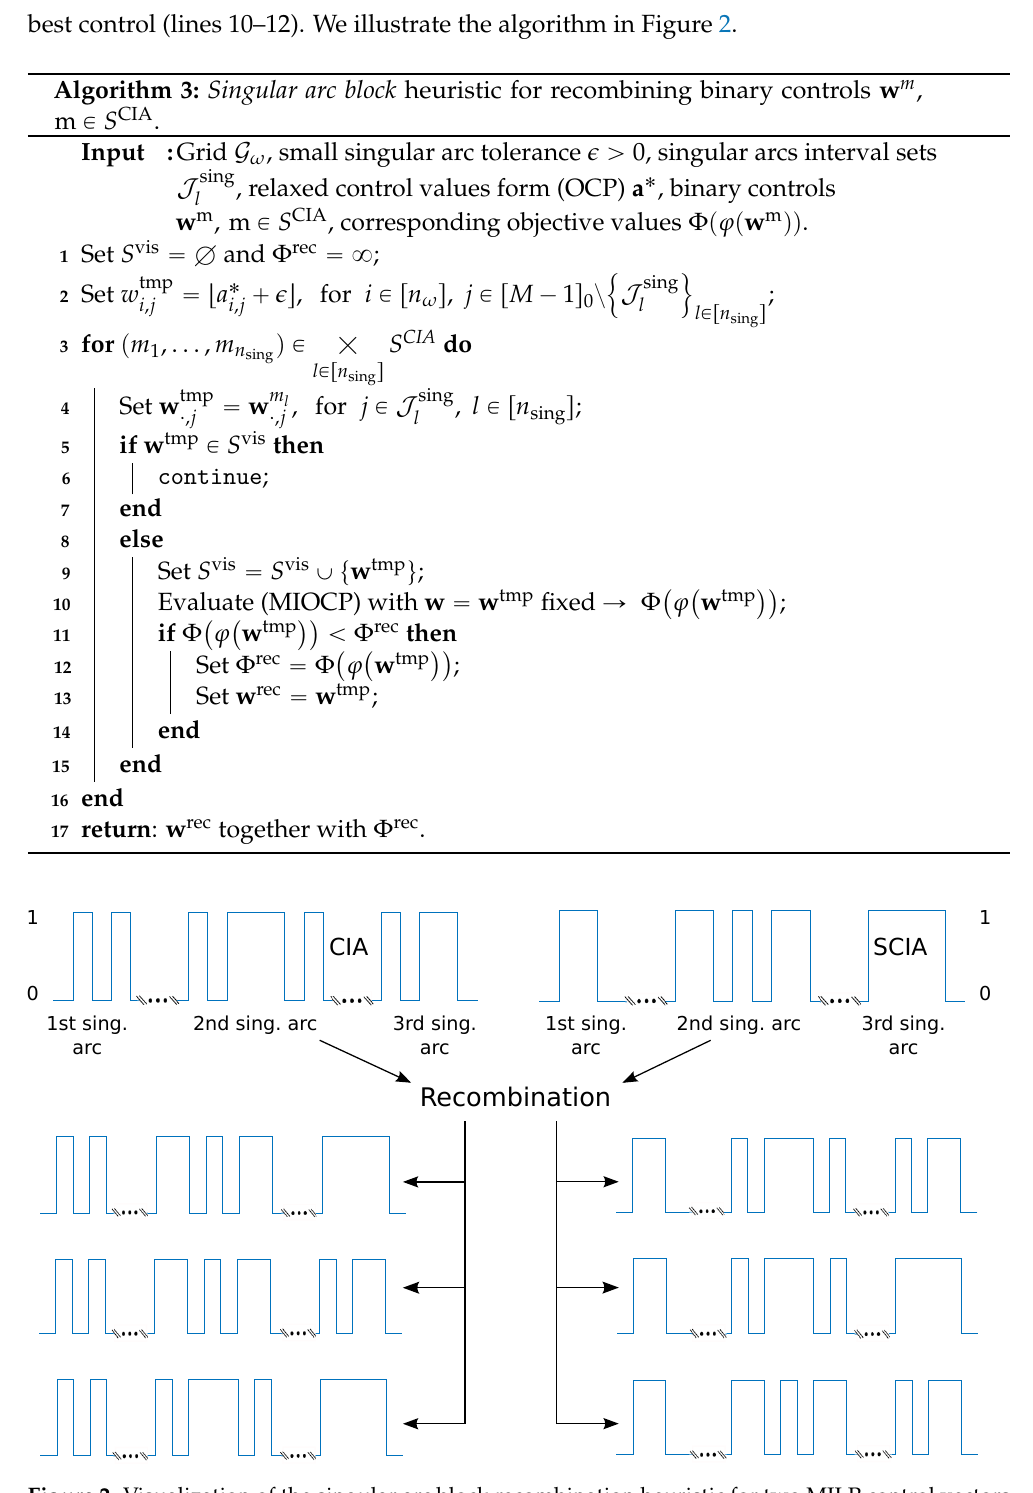
Figure 2. Visualization of the singular arc block recombination heuristic for two MILP control vectors (which we name CIA and SCIA) with three singular arcs. Every possible variation from the singular arcs and candidate controls is generated and we evaluate (MIOCP) for each of the constructed variation. The minimal objective value of all variations represents the heuristic’s